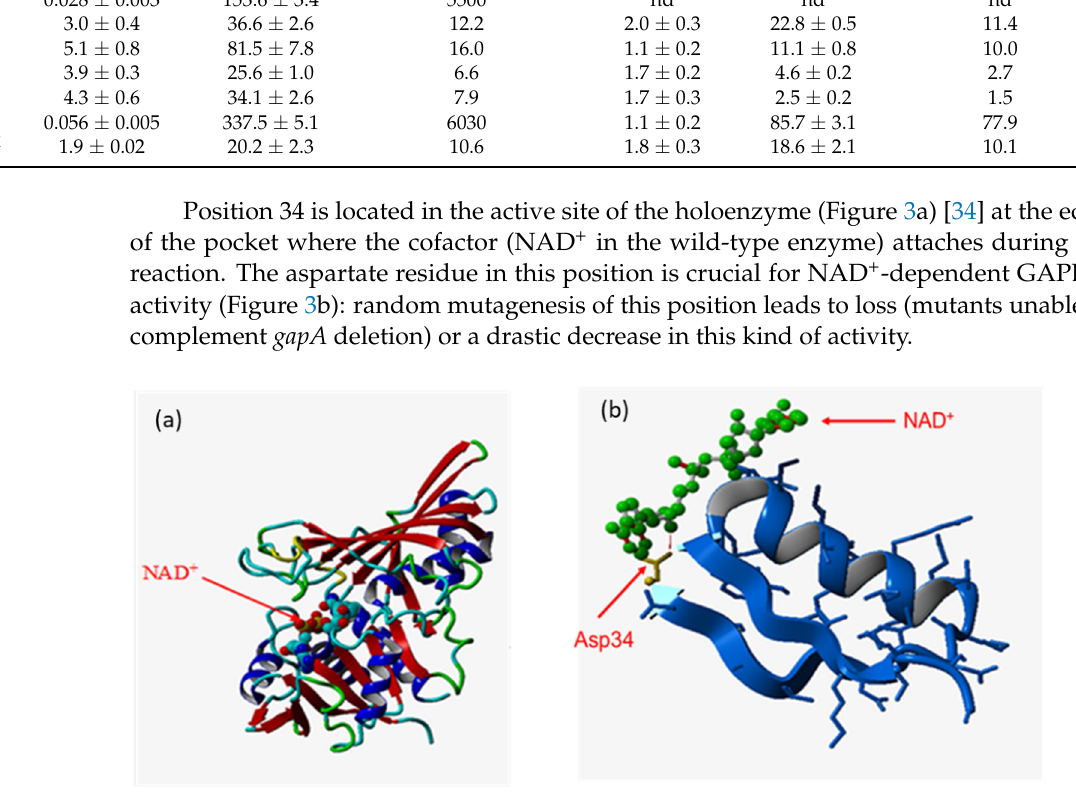
Figure 3. Ribbon diagram representation of the 3D structure of GAPDH E. coli. ( a ) a subunit of wild- type GAPDH with the specified position of the coenzyme-binding site. ( b ) wild type: fragment of 1 to 40 amino acid residues with a coenzyme-binding site. In yellow—residue D34, in green—NAD +